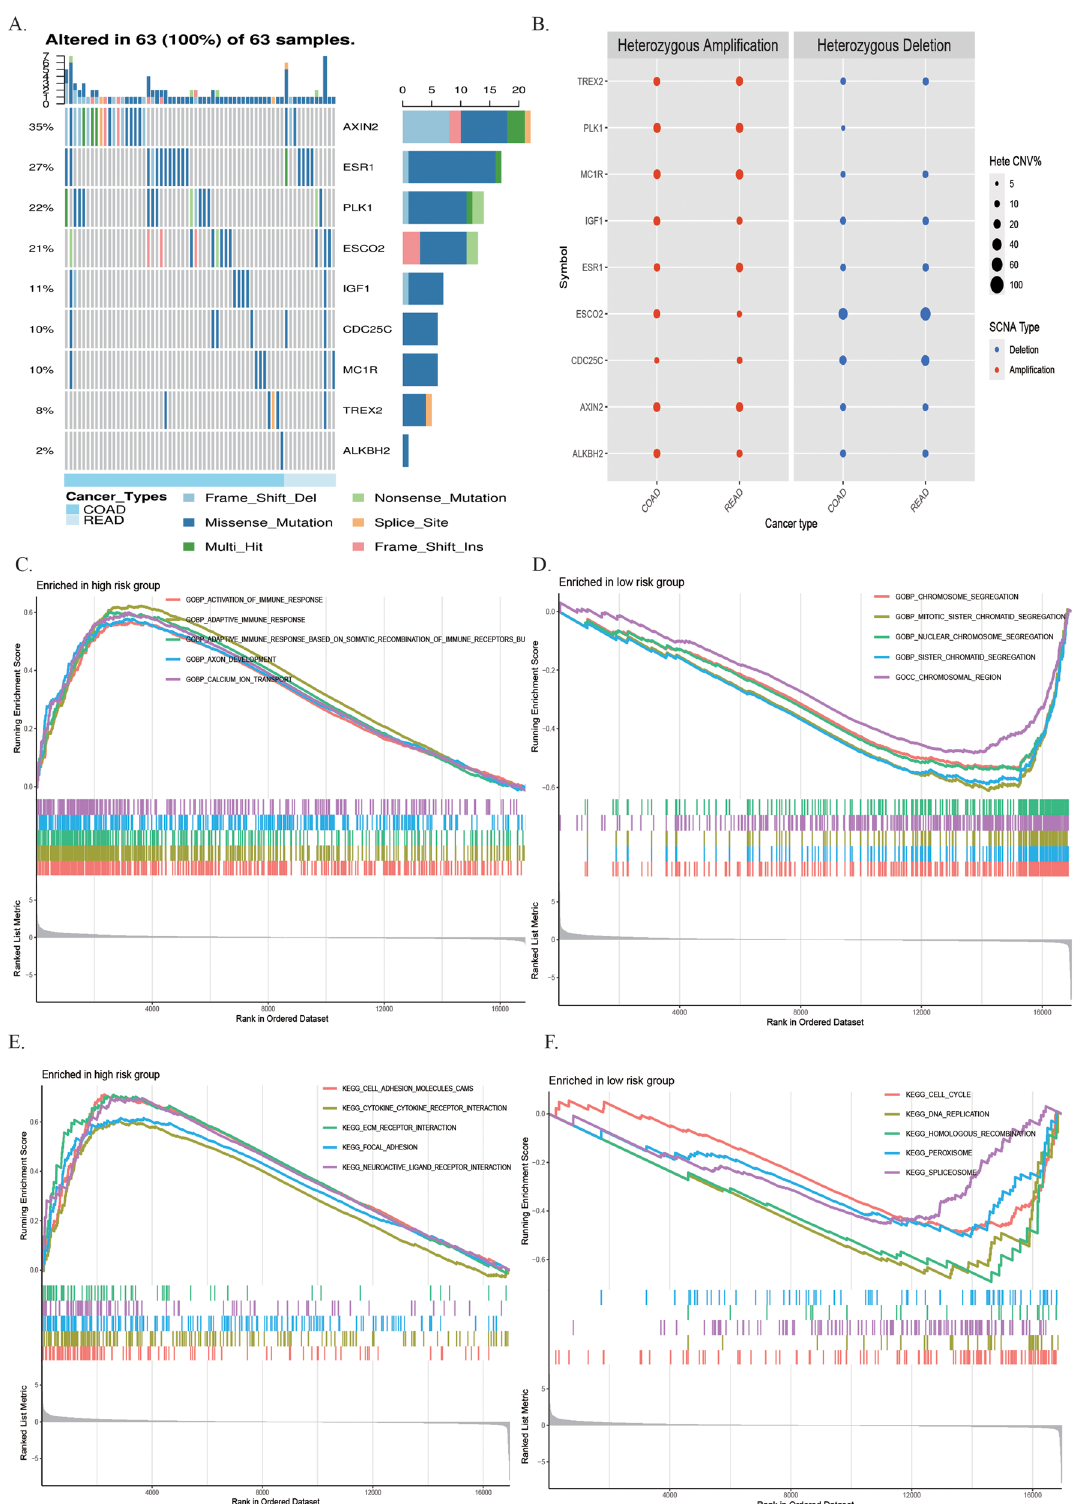
Figure 5. Analysis of genetic alterations, involved signaling pathways and immune correlation of DRGs in CRC. (A) Genetic alterations of the 9 DE-DRGs in the CRC cohort. X axis represents cancer type, sky blue indicates COAD, light blue indicates READ. The left Y axis represents ratio of gene mutation, right Y axis represents gene names. Dark blue, cyan, and pink small rectangles indicate the type of gene mutation. (B–D) GO and KEGG enrichment analysis of the 9 DE-DRGs. (D,E) The scores of 16 immune cells and 13 immune- related functions are displayed in boxplots. CCR, cytokine-cytokine receptor. Adjusted P values were showed as: ns not significant; *P < 0.05; **P < 0.01; ***P <